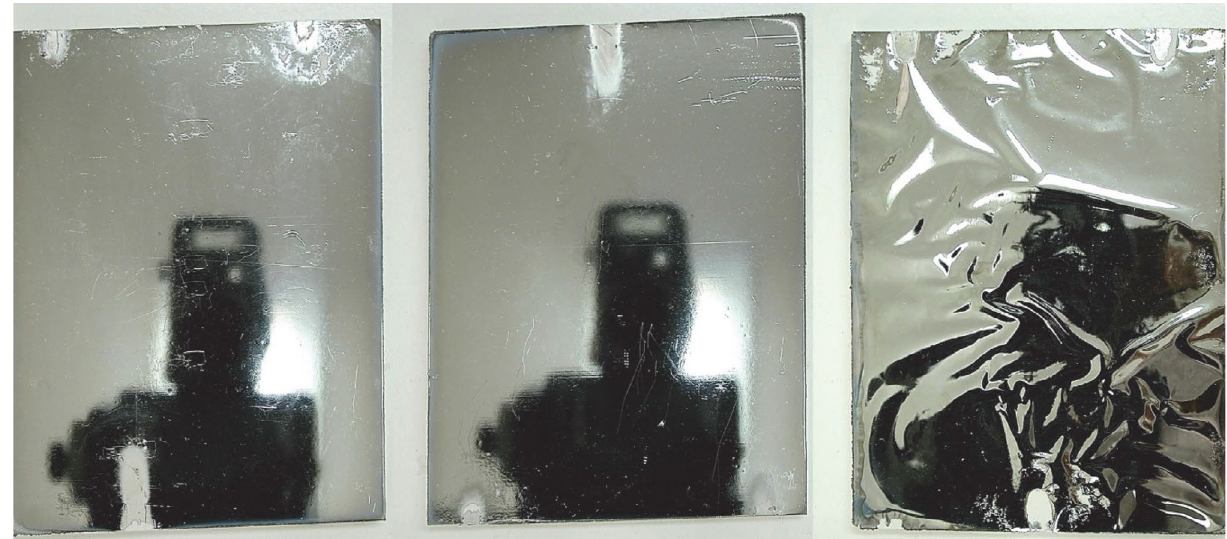
Figure 6. White-ABS premetallized with Ni-JetMetal® and electrolytic deposition of Cu-Ni-Cr: (a) sulfuric-chromic bath for 10 min; (B) sulfu- ric-chromic bath for 15 min; (C) KMnO 4 for 15